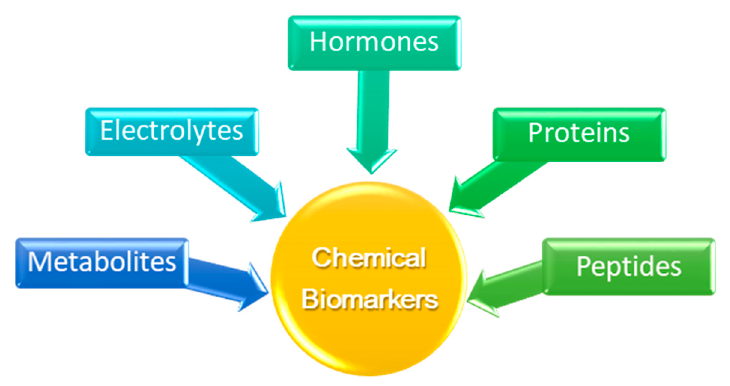
Figure 6. Chemical biomarkers that can be detected via wearable chemosensors.